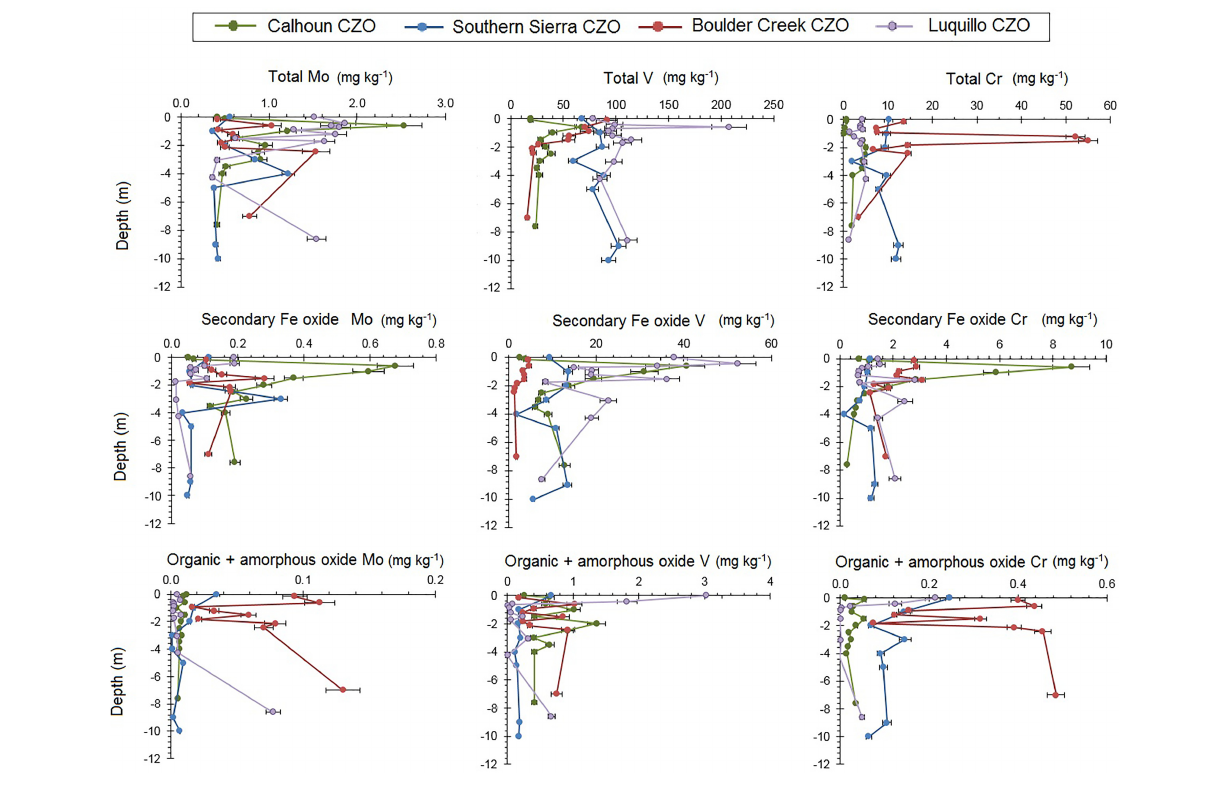
Using Pearson correlations, we observed that total Mo, V, and Cr were correlated with secondary oxide Fe concentrations [a proxy for long-range ordered to crystalline Fe oxy(hydr)oxides] ( Table 2 ). At Calhoun CZO, secondary oxide and total Mo, V, and Cr concentrations were positively correlated with secondary oxide Fe concentrations. For Southern Sierra CZO, secondary oxide V and Cr were positively correlated with secondary oxide Fe concentrations. At Boulder Creek CZO, secondary oxide and total concentrations of V and Cr were negatively correlated with both secondary oxide Fe and TOC. At Luquillo CZO,